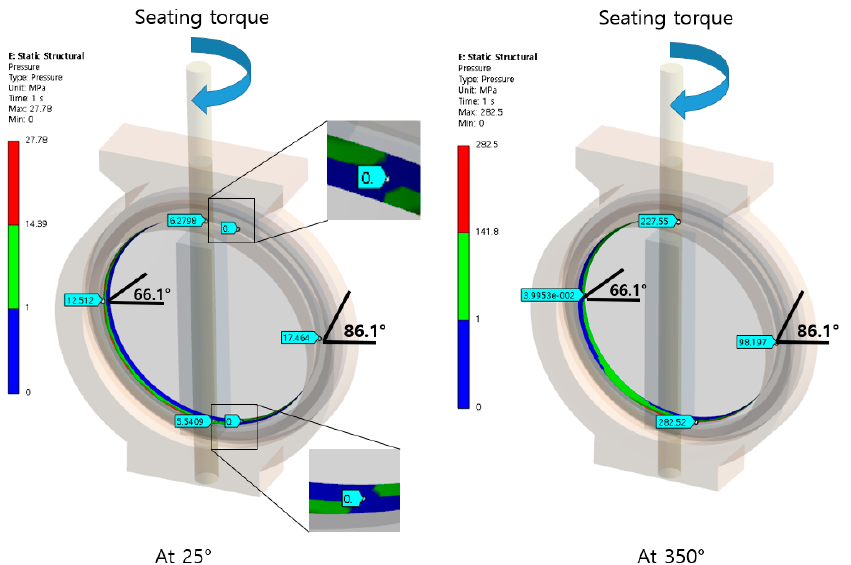
Figure 15. The contact pressure distribution of the one-layer model. The contact pressures of the three-layers at the angles of 86.1 ◦ and 66.1 ◦ were 2.92 MPa and 8.51 MPa at 25 ◦ C, and 42.9 MPa and 154.25 MPa at 350 ◦ C, as shown in Figure 16. Leakage did not occur, and compared with the one-layer model at 350 ◦ C, the contact pressures were reduced compared with one-way, but they were still too much larger than the working pressure (1 MPa).